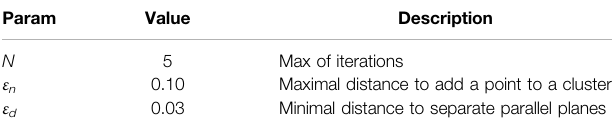
TABLE 1 | Parameters for the planar segmentation. Param